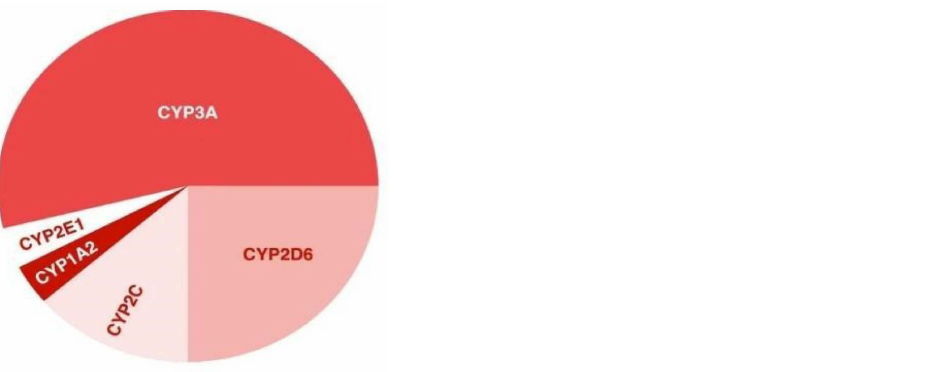
Figure A3. Estimated percentage of antipsychotics metabolized by the major cytochrome P450 enzymes [49].